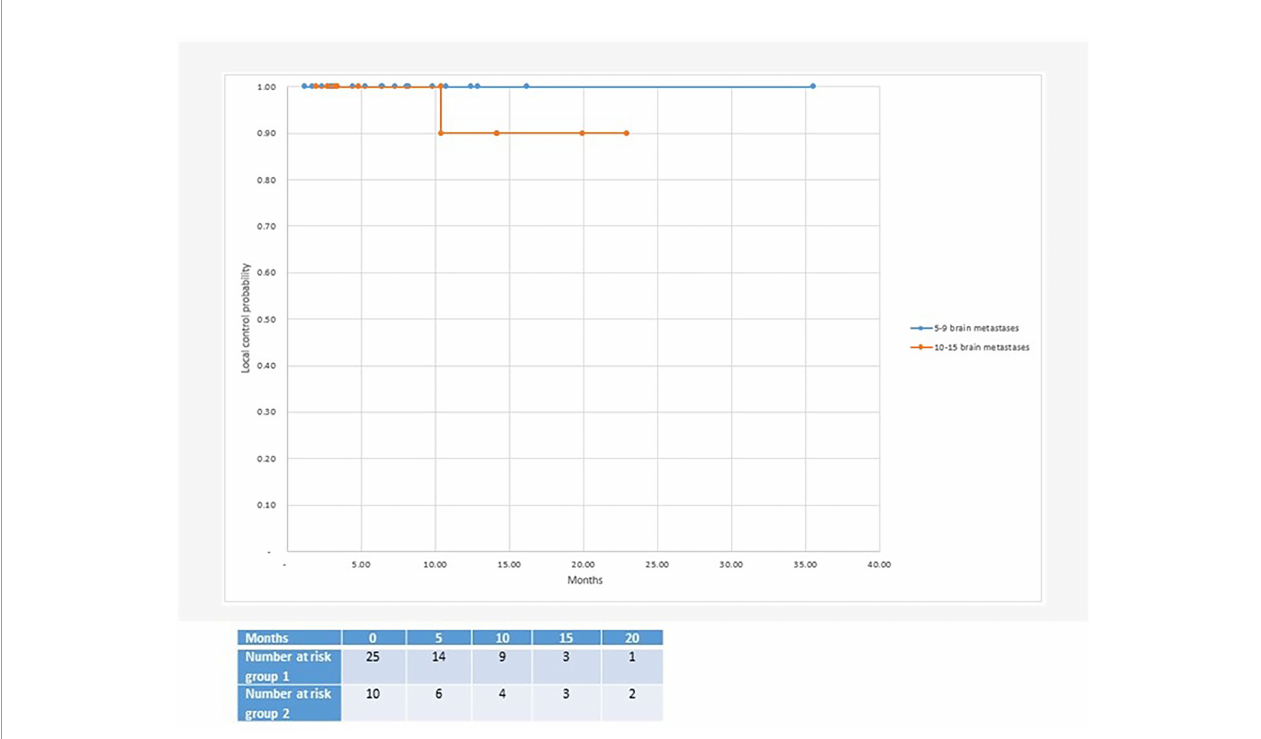
FIGURE 1 | Median local control after radiosurgery for 5 or more brain metastases: Group 1 with 5-9 brain metastases (100% local control at 35 months follow-up) and group 2 with 10-15 brain metastases (90% local control at 23 months